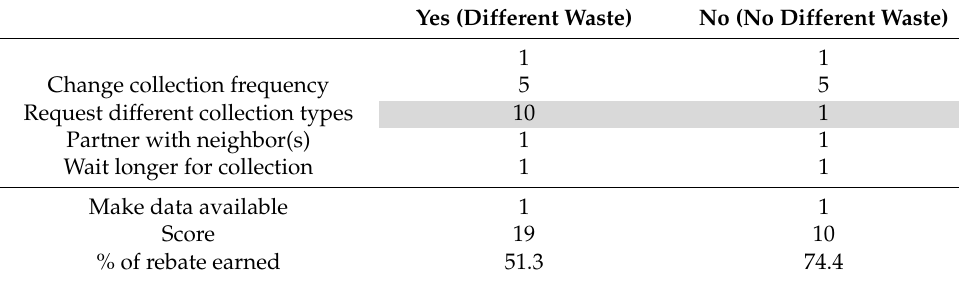
Table 4. Impact of scheduling the collection of different types of waste.